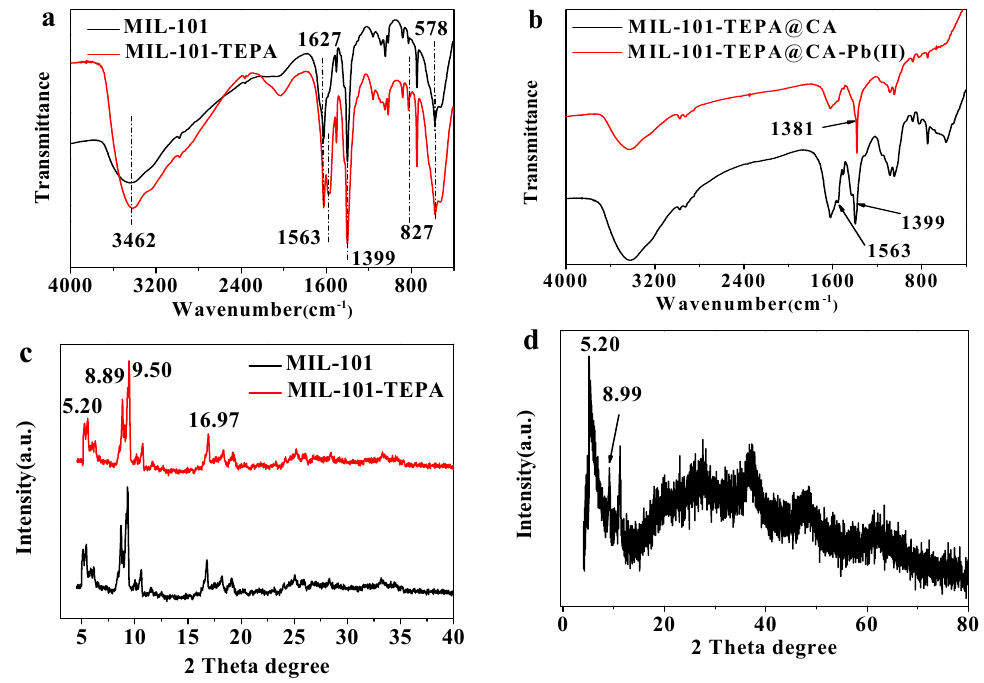
Figure 2. Fourier-transform infrared (FTIR) spectra of ( a ) MIL-101 and MIL-101-TEPA; ( b ) MIL-101-TEPA@CA and MIL-101-TEPA@CA-Pb(II); XRD patterns of ( c ) MIL-101 and MIL-101-TEPA; and ( d ) MIL-101-TEPA@CA.